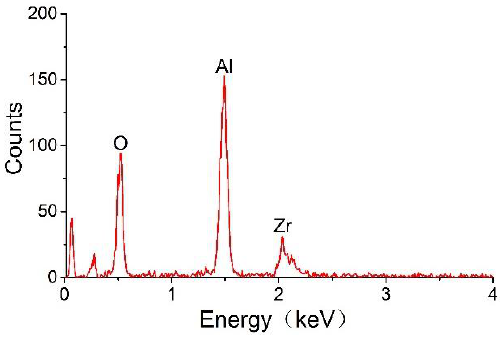
Figure 6. Energy spectrum of the sensor carrier.